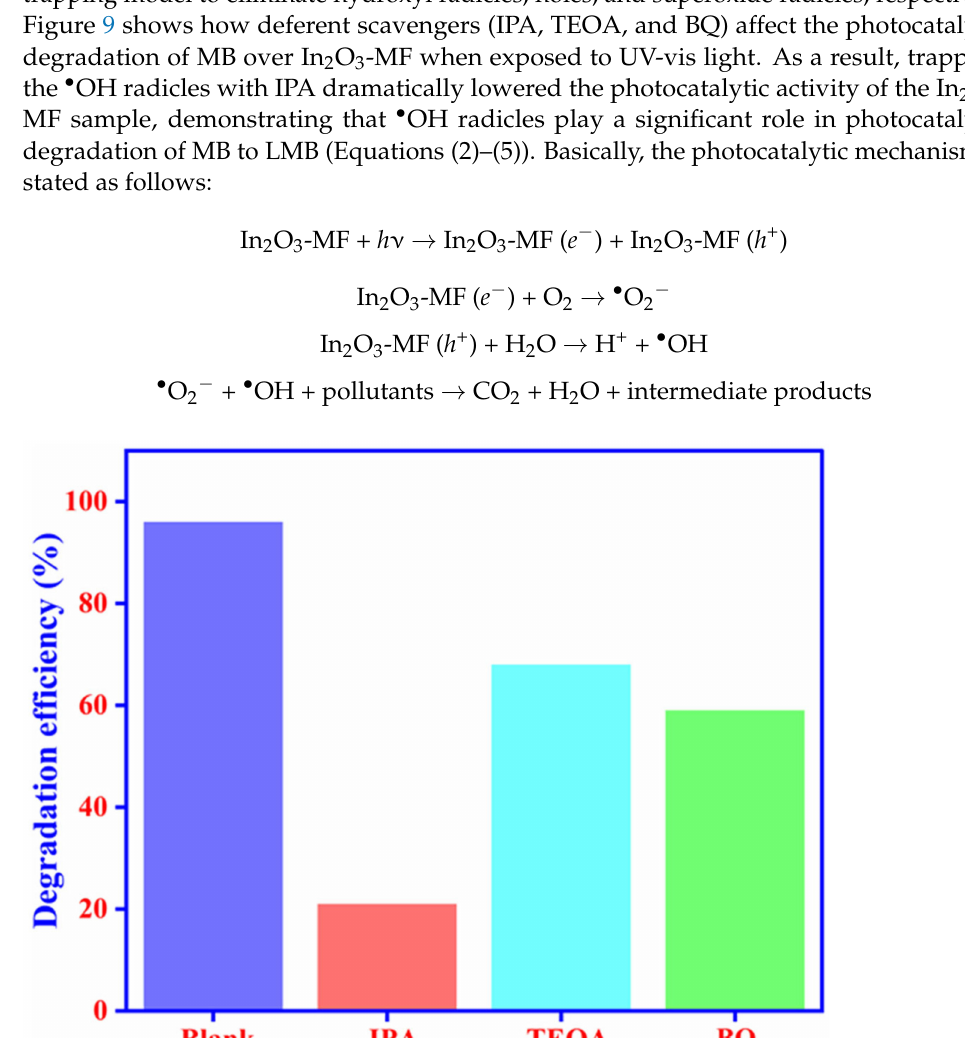
MB using In 2 O 3 -MF as